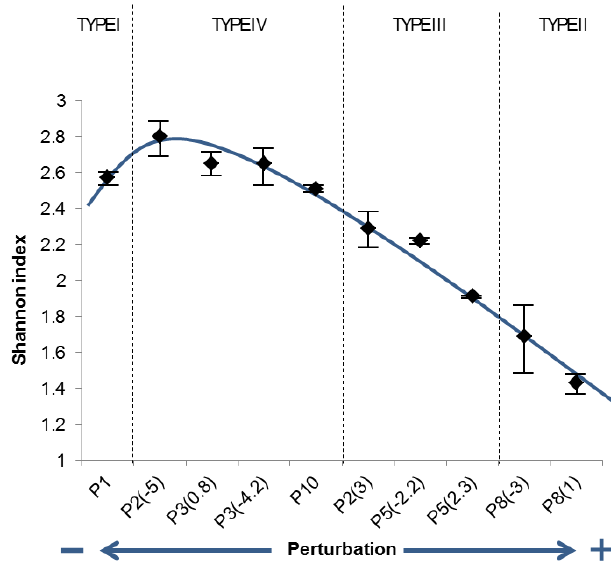
Figure 6. Average of Shannon indices in piezometer samples under wet conditions. Standard deviation is shown in error bars. Horizon- tal axis reflects the degree of perturbation of original groundwater due to